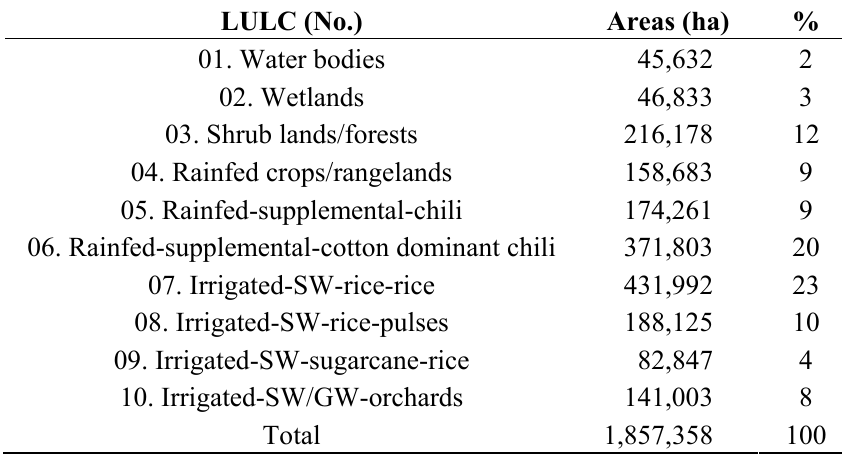
Table 2. Distribution of crop dominance classes with other land use/land cover for the 10 final classes.